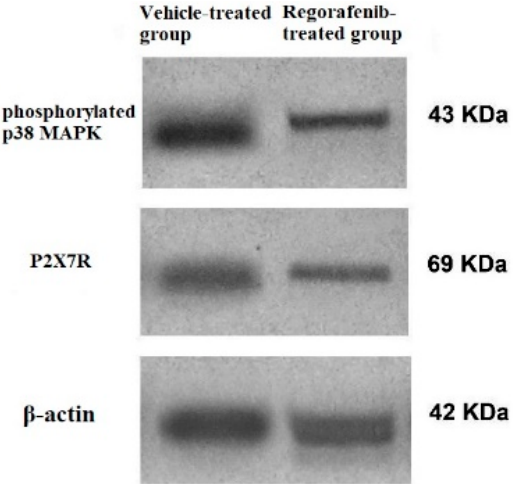
Figure 4. Western blot of P2X7R, phospho-p38 MAPK. and β -actin in regorafenib-treated and vehicle-treated groups.